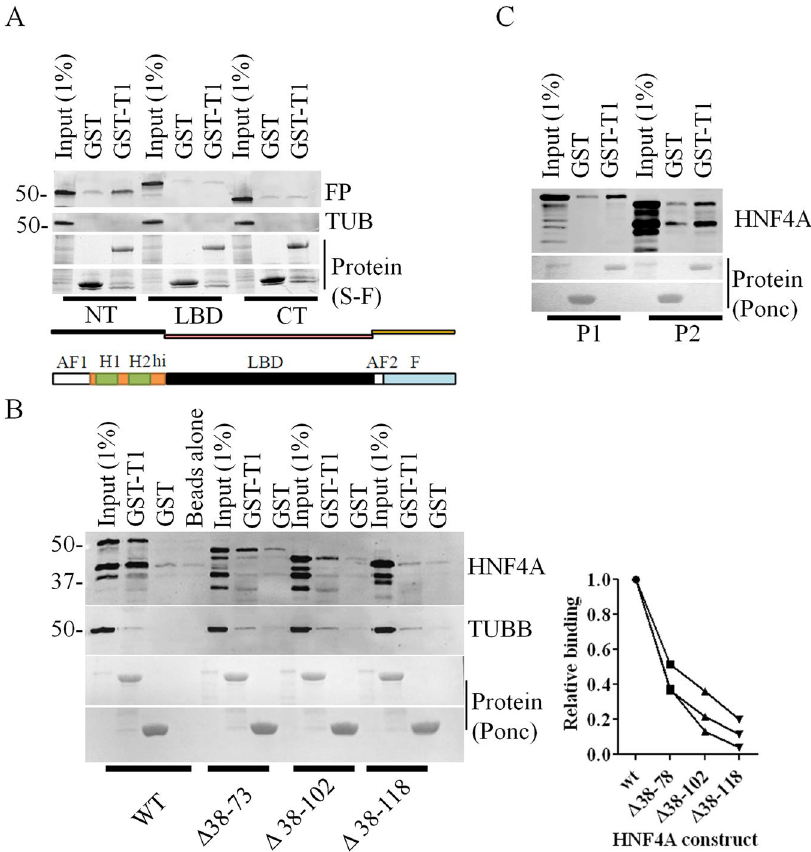
Figure 7. HNF4A interacts with TRIB1 via its N-terminus. Fragments ( A ) or deletions ( B ) of the HNF4A P2 variant or the full-length P1 or P2 variants of HNF4A ( C ) were expressed in HEK293T cells and subjected to pull-downs using either GST or GST-TRIB1 (GST-T1). Results are representative of three independent pull- down assays. In B, quantification of three distinct pull-downs ( ± S.D) is shown; quantification was performed using the high molecular band of each form and is expressed relative to Wt binding (see Methods). Total protein was resolved on a 4–15% gradient ( A ) or a 10% SDS-PAGE gels ( B,C ). Proteins were imaged using either Stain- Free methodology (“S-F”, A) or Ponceau (“Ponc”, B and